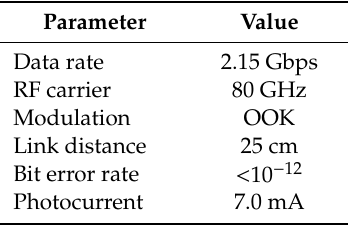
Table 1. Wireless link with one active PD: summary of main